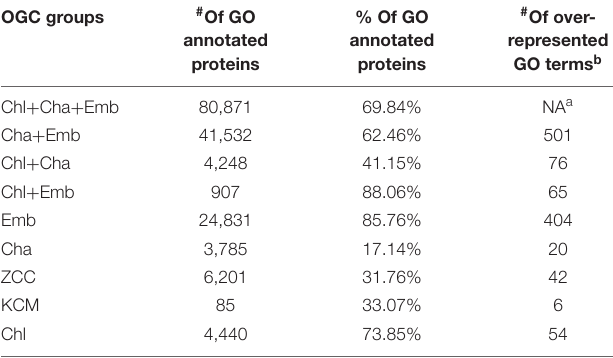
TABLE 4 | Overview of gene ontology (GO) annotation for OGCs of the nine